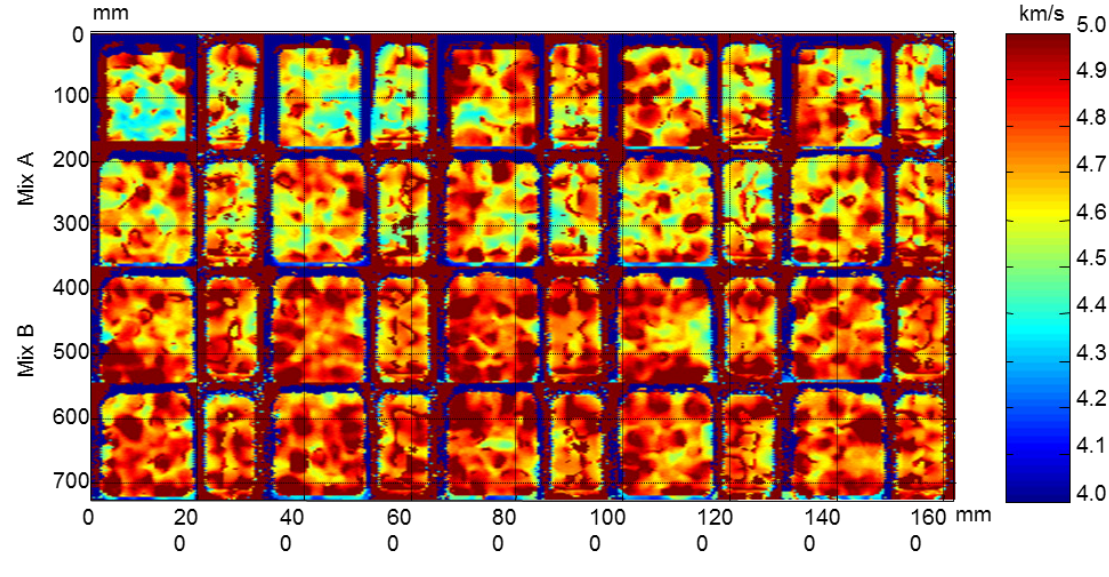
Figure 24. Velocity maps of concrete specimens before the cycles.